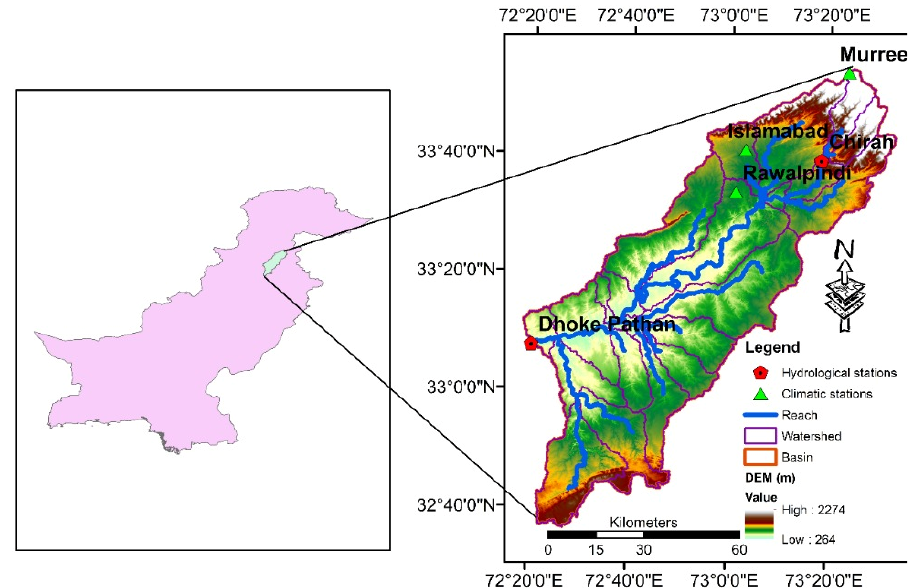
Figure 1. Study area